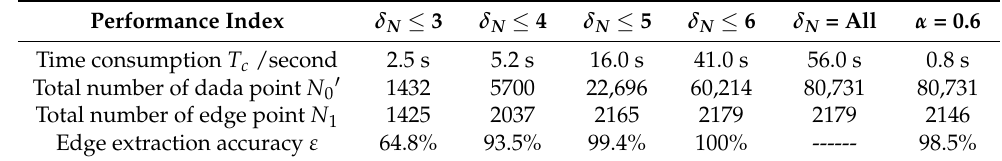
Figure 16. The statistical CDTM-based boundary extraction on experimentally laser-scanning point cloud data of a complex-shaped mechanical parts. Table 3. The performance comparison among different boundary extraction method conducted on the actual point cloud data of experimental workpiece.